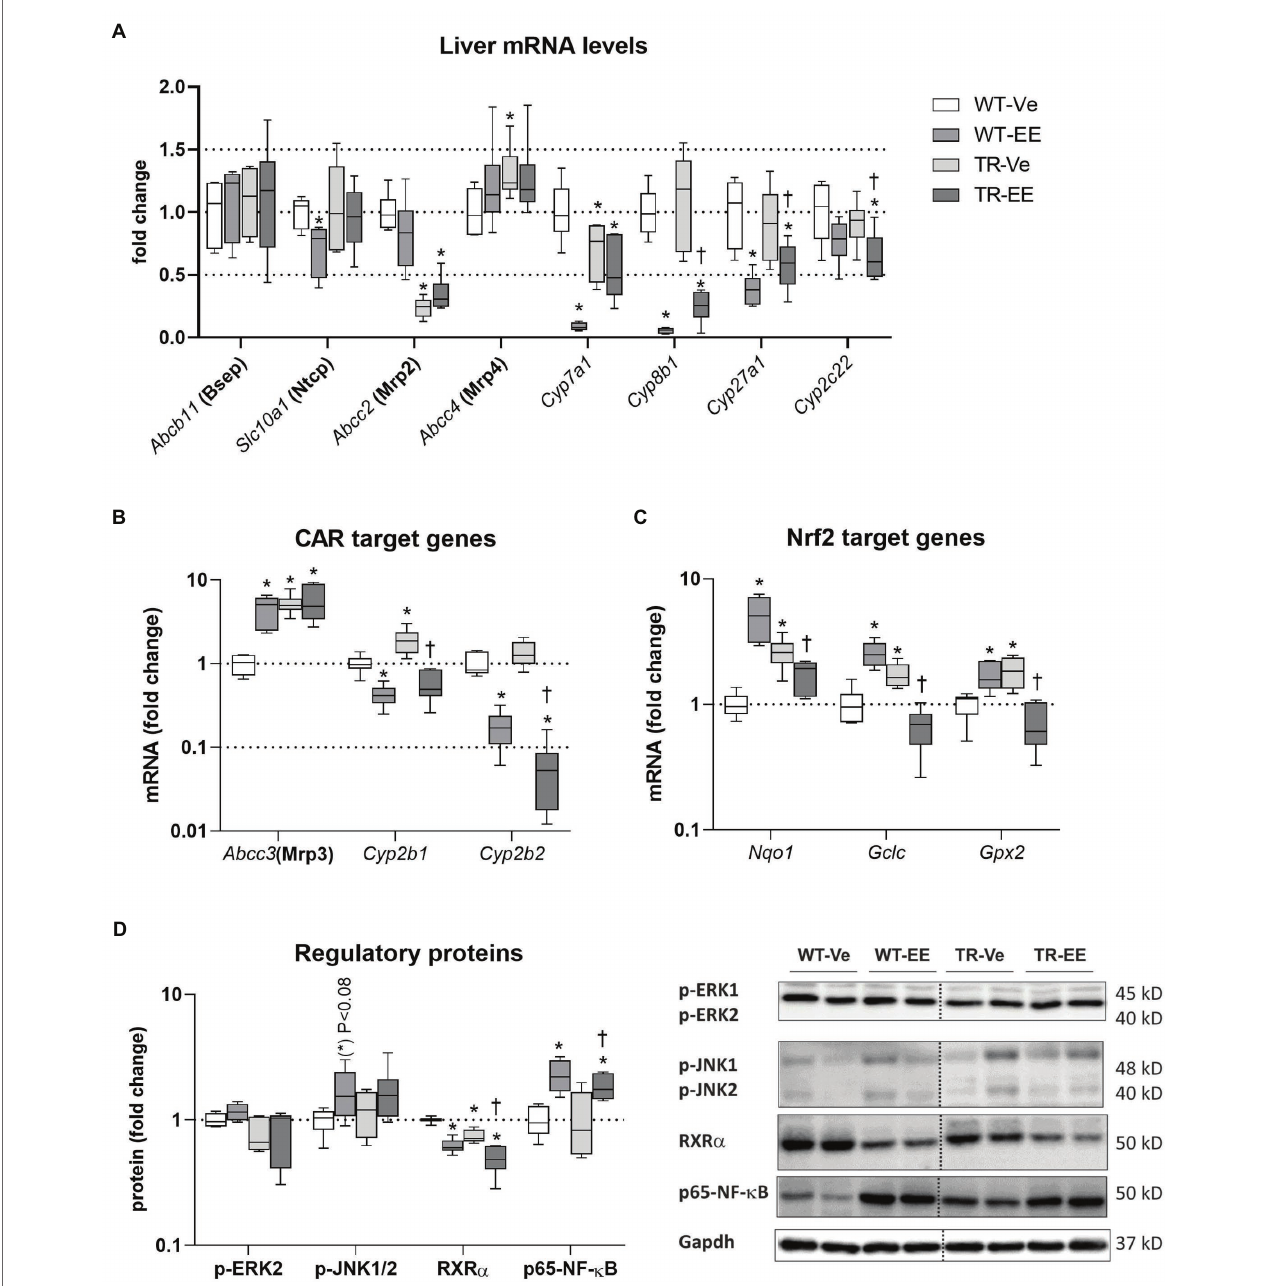
FIGURE 7 | Effect of ethinylestradiol and Mrp2 deficiency on the mRNA or protein expression of pathways regulating bile acid homeostasis in the liver. Experimental groups: WT-Ve, WT rats receiving vehicle; WT-EE, WT rats receiving ethinylestradiol; TR-Ve, TR rats receiving vehicle; and TR-EE, TR rats receiving ethinylestradiol. (A) The mRNA expression of crucial bile acid synthetizing and transporting molecules in the liver. (B) The expression of genes regulated by constitutive androstane receptor (CAR). (C) The expression of Nuclear factor erythroid 2-related factor 2 (Nrf2) target genes. (D) Protein expression of key intracellular signaling molecules involved in the regulation of bile acid metabolomics. Protein and mRNA levels were normalized to Gapdh expression. Dotted line shows where irrelevant bands were omitted. Data are presented as medians, with boxes and whiskers representing the interquartile range and 5th-95th percentiles, respectively. Significance: * p < 0.05, compared to vehicle-treated WT rats; † p < 0.05 compared to vehicle-treated TR